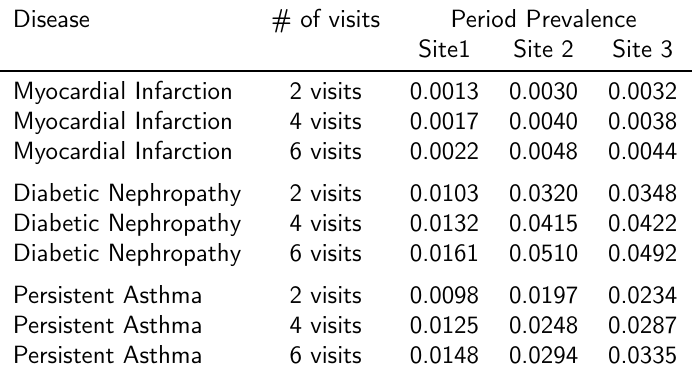
Table 2: Variation in period prevalence (2016) of three diseases with increase in minimum number of health care visits required to enter the study sample, in participants aged 46-65, by